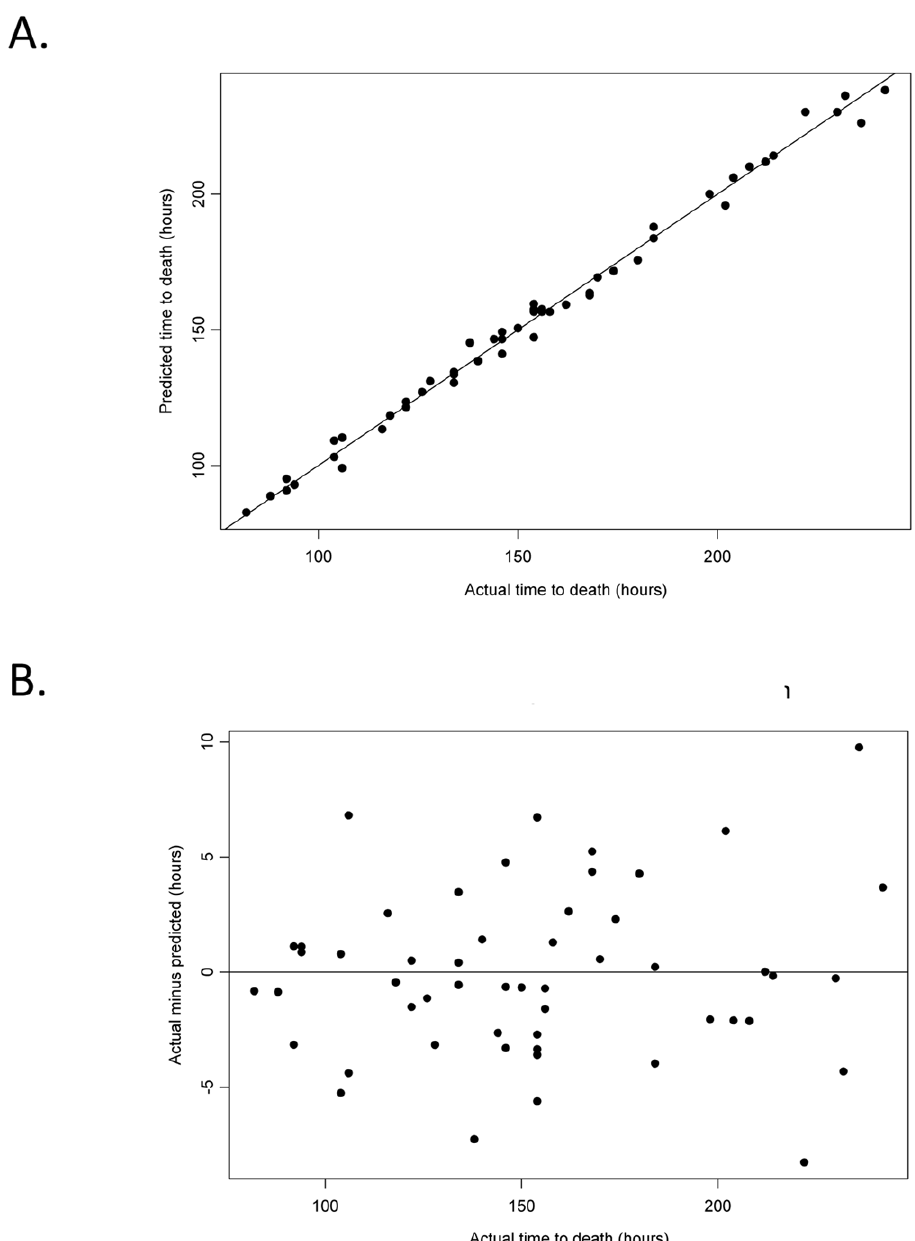
Figure 3. Predicted time of death (based on change point 2) versus observed time of death. A) The correlation between predicted time of death and observed time of death are shown for all mice (black dots) infected with F. tularensis groups (A1a, A1b, A2 and type B) in both round 1 and round 2. The solid black line represents 100% correlation. B) The observed time of death minus the predicted times of death are shown for all mice (black dots) infected with F. tularensis groups (A1a, A1b, A2 and type B) in both round 1 and round